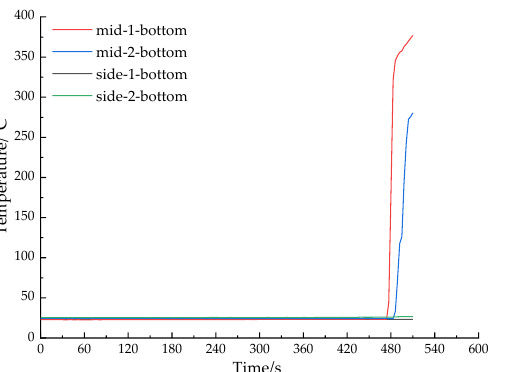
temperature of the side-1-bottom increases from 23.2 ◦ C to 23.3 ◦ C, the temperature of the side-2-bottom increases from 25.4 ◦ C to 26.6 ◦ C, and there is no obvious temperature change at the two measuring points.